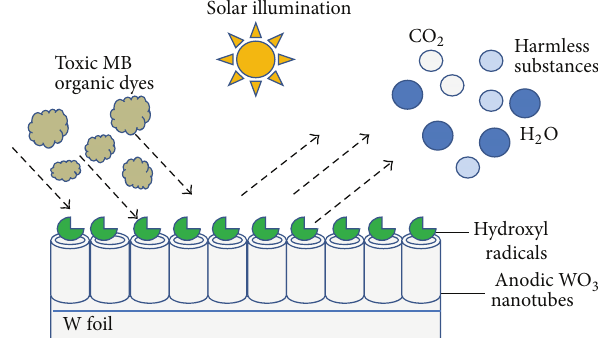
Figure 6: Schematic illustration of basic principal photocatalytic degradation of MB dye under solar illumination assisted by anodic WO 3